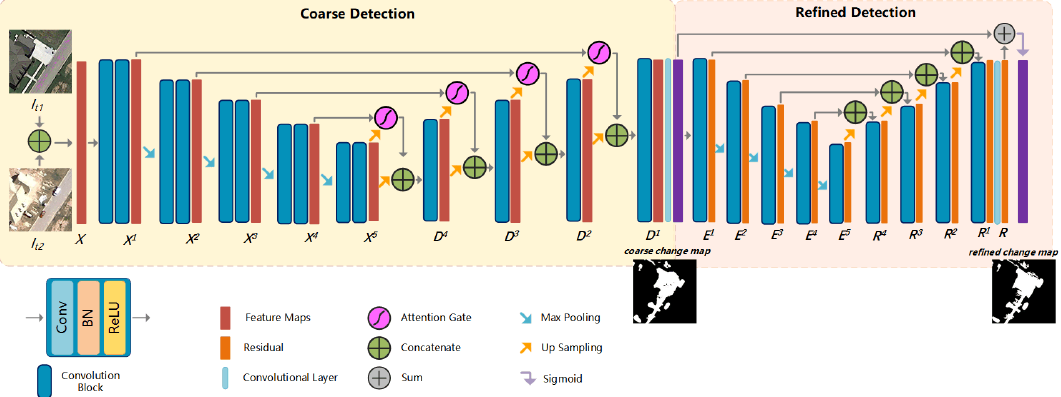
Figure 1. Illustration of our BA 2 Net architecture. The whole network contains two Encoding-Decoding subnets, each of which is composed of several convolutional blocks and skip connections. All convolutional blocks are with unified structures as Convolutional + BatchNormalize + ReLU layers with different parameters settings. The output of BA 2 Net, refined change map (RCM), is sigmoid sum of the coarse change map (CCM) and the refined residual ( R